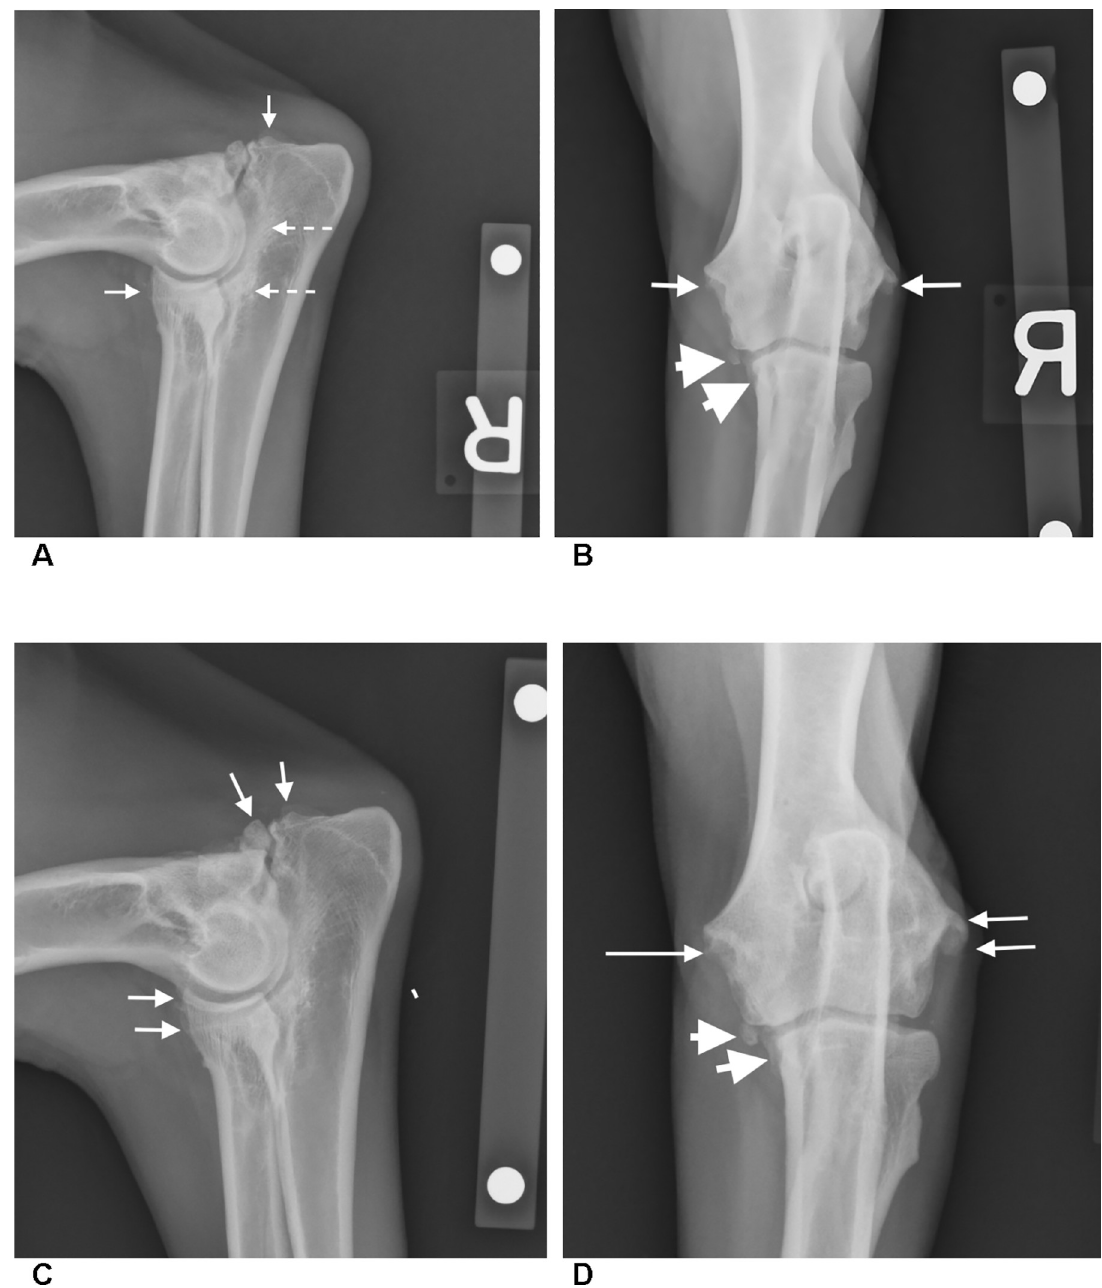
Fig 1. Baseline and Day 365 radiographic comparison of the right elbow of dog 2-15L3. Mediolateral (ML, view 1A) and craniocaudal (CC, view 1B) radiographs of the right elbow are shown at baseline. In the ML view, sclerosis of the trochlear notch of the ulna is present (dotted arrows). An irregular gap is present between the anconeal process and the olecranon due to an ununited anconeal process. In the CC view, moderate periarticular osteophytosis (arrows) are present at the humeral epicondyles, and anconeal process. The margins of the medial coronoid process are blunted and there is a small osseous fragment present (arrow heads). In the ML view at Day 365 (1C), there is mild progression with osteophytes at the cranial border of the radial head and epicondyles of the humerus, and anconeal process at the site of the ununited anconeal process (white arrows). In the Day 365 CC view (1D), the osseous fragment at the medial coronoid process (arrows) is slightly increased in size and the blunted process is unchanged (arrow heads). Sclerosis of the trochlear notch is static.